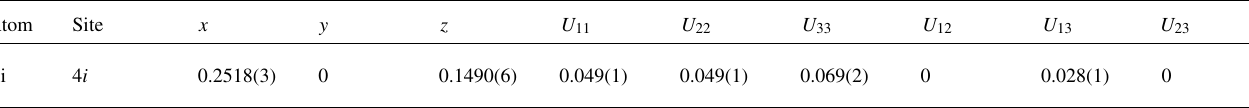
Table 2. Atomic coordinates and displacement parameters (in Å 2 ) .